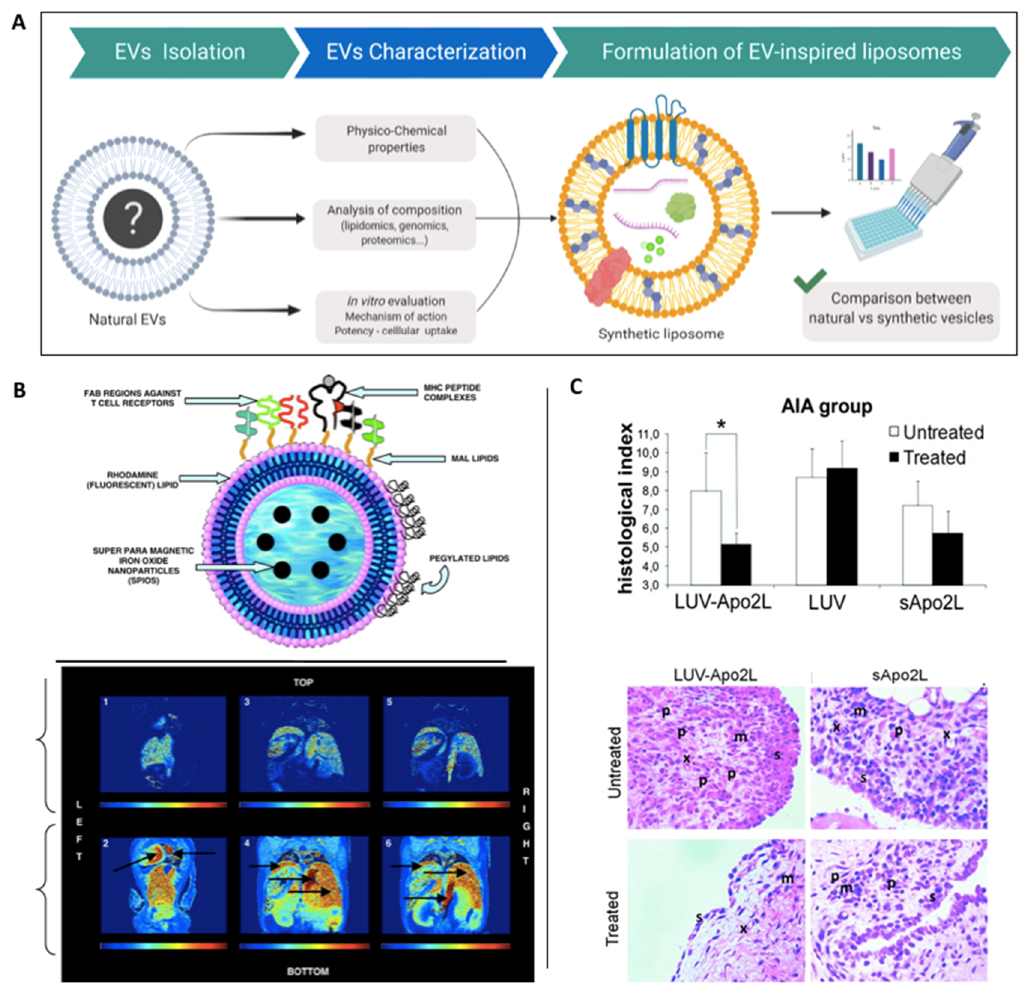
Figure 5. The use of EV-inspired liposomes as therapeutic nanoparticles. ( A ) Schematic illustration representing the general strategy in mimicking the composition and therapeutic potency of naturally-derived EVs with EV-inspired liposomes (EVLs). ( B ) Liposomes incorporated with MHC Class I peptide complexes and ligands to facilitate adhesion, early/late activation and survival T cell receptors (upper panel). Incorporation of superparamagnetic particles allows for the tracking of these EVLs in vivo (lower panel). Reproduced from [110], with permission from Elsevier, 2009. ( C ) Liposome conjugated with APO2L/TRAIL (LUV-APO2L) substantially reduced inflammation within a rabbit model of antigen-induced arthritis model. Reproduced from [112], with permission from John Wiley and Sons, 2010. *, p <